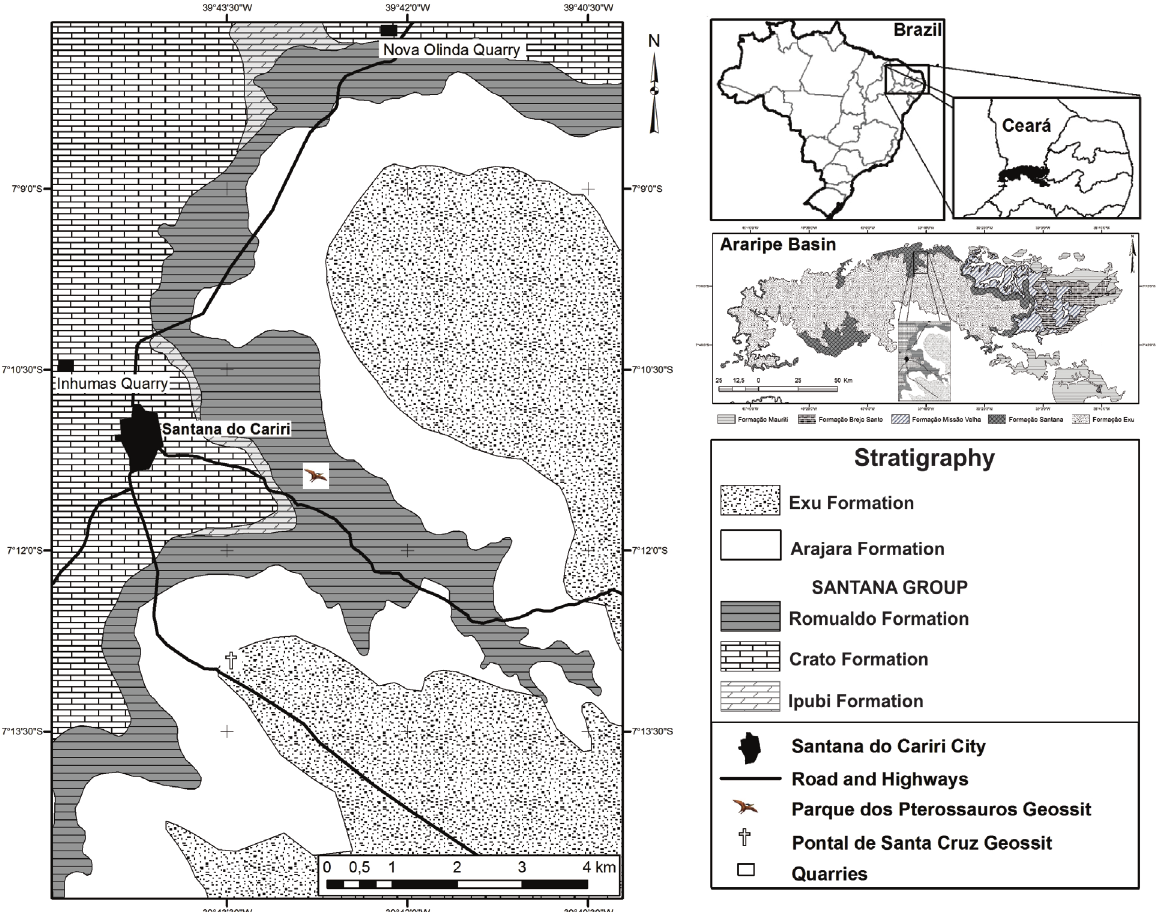
Figure 1. Map of geographical area and lithologic distribution in the Araripe Basin, with details of the region of Nova Olinda and Santana do